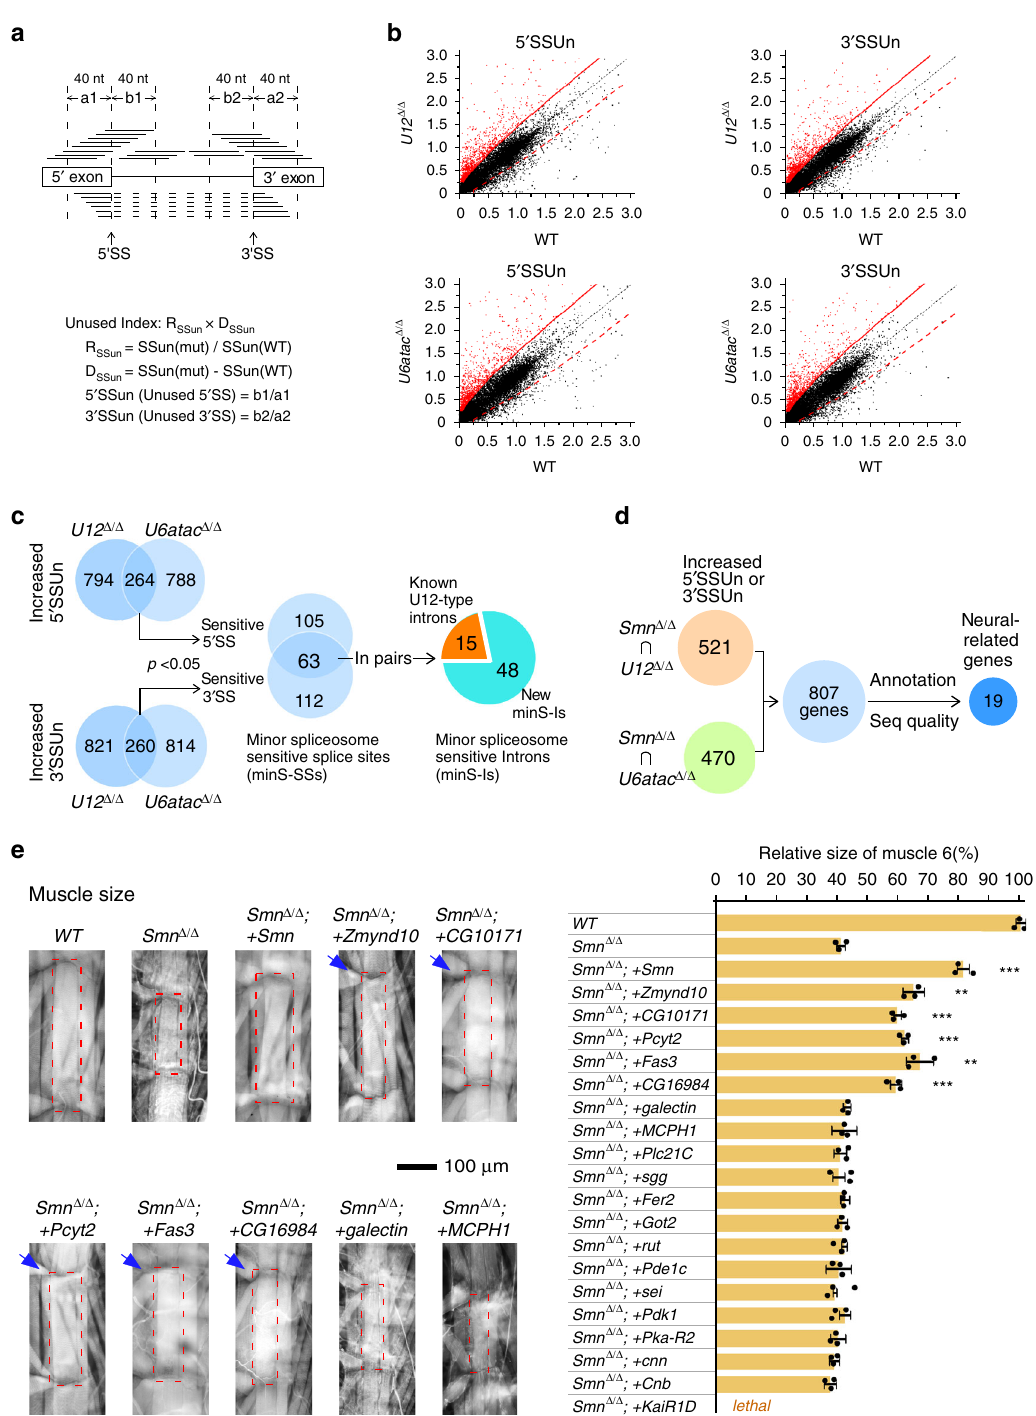
Fig. 2 Identi fi cation of minor spliceosome-sensitive splicing events and candidate genes for the rescue of SMA-associated phenotypes. a Diagram of bioinformatic analyses for identifying minS-Is. For details see methods. b Distribution of SSun scores of transcriptome-wide 5 ′ SSs and 3 ′ SSs in the mutant strain ( U12 Δ / Δ or U6atac Δ / Δ ) versus the WT strain. Grouped by a red unbroken limitation line, red dots represent the top 2% of SSun scores in the mutant strains; and black dots represent the remaining SSun scores, where a symmetric red dashed control line is indicated. c Splice sites and introns that are sensitive to the two minor-snRNA deletions. Decreased usage of the 5 ′ and 3 ′ SSs are identi fi ed and paired. minS-Is are grouped into known U12-type introns and new minS-Is. d Selection of neural genes with defective 5 ′ SS or 3 ′ SS in both Smn deletion and minor-snRNA deletion strains. e Development of muscle 6, indicated within the dashed red rectangles, is rescued by fi ve neural genes. Positive genes are indicated by blue arrow; additional transgenic strains with neural expressed CDSs of candidate genes are presented in Supplementary Fig. 4b ( Smn Δ / Δ ; + Smn : p = 2e − 5; Smn Δ / Δ ; + Zmynd10 : p = 0.00281; Smn Δ / Δ ; + CG10171 : p = 8.5e − 5; Smn Δ / Δ ; + Pcyt2 : p = 5.5e − 5; Smn Δ / Δ ; + Fas3 : p = 0.00583; Smn Δ / Δ ; + CG16984 : p = 0.00025). Data represent the mean ± SD from fi ve representatives of each strain. ** p < 0.01 and *** p < 0.001. P values were calculated using two-sided t -test. Source data are provided as a Source Data fi